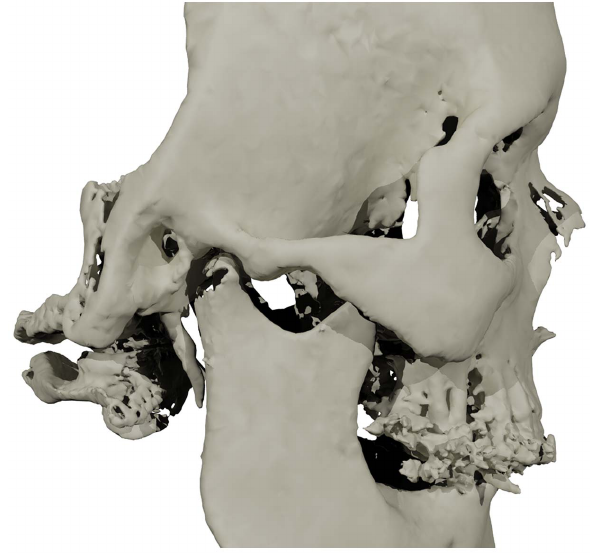
Figure 1. A 3D rendered virtual head model of a patient from Maxilim, reconstructed from the original CBCT data. The inaccurate reconstruction of the condyle is clearly visible. No measurement of the condylar shape or volume can be made due to the discontinuity of the condylar surface.